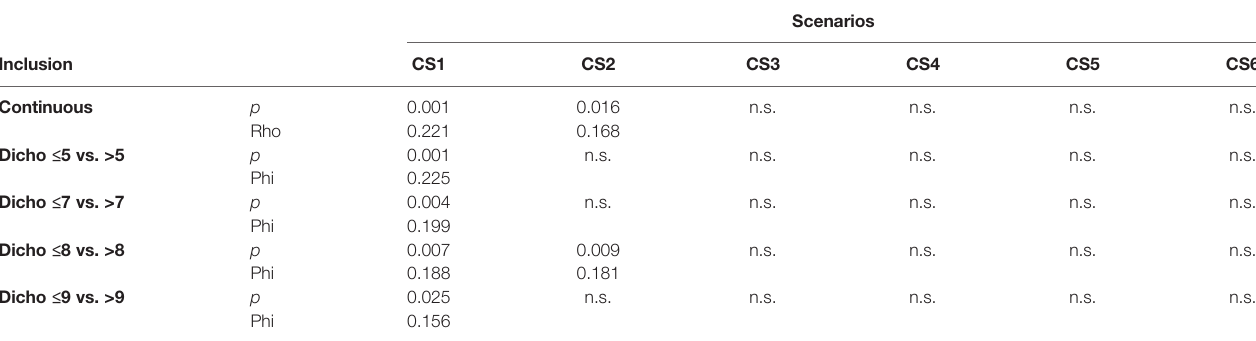
TABLE 1 | Unadjusted relationship between number of cases and guideline-adherent treatment